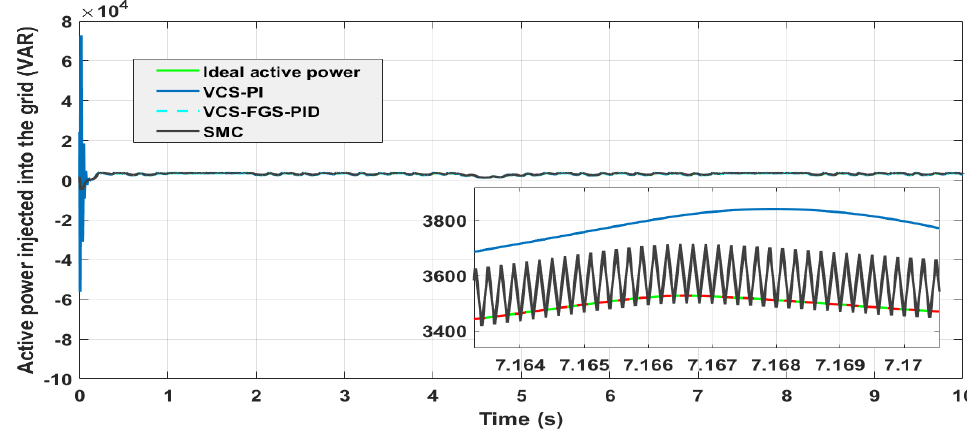
Figure 33. Quadratic stator current.